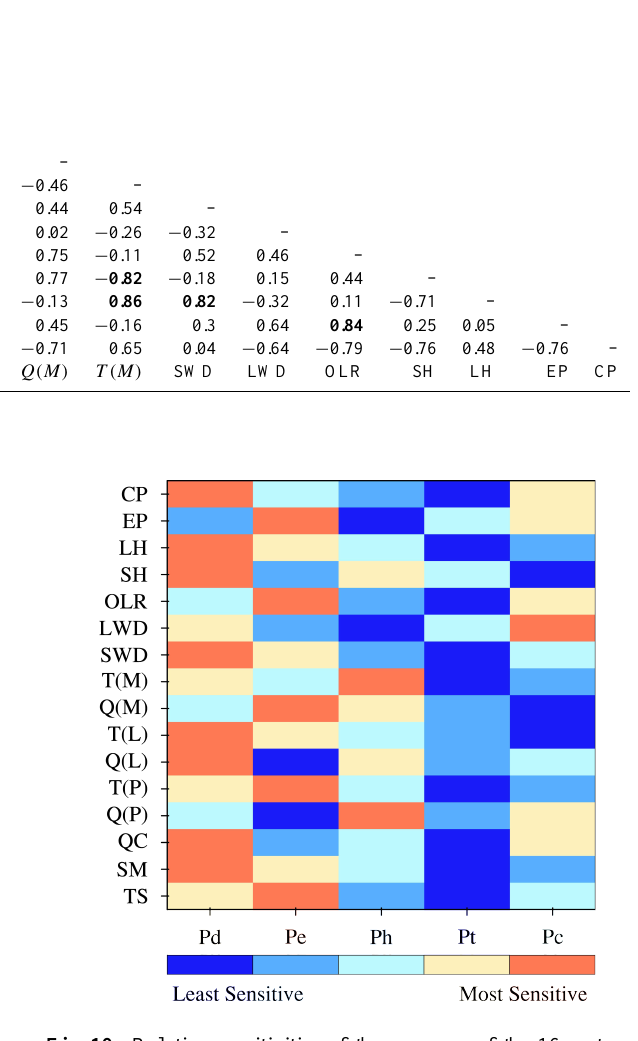
Fig. 10. Relative sensitivities of the response of the 16 meteoro- logical variables (see Table 3) to the five CPS parameters (see